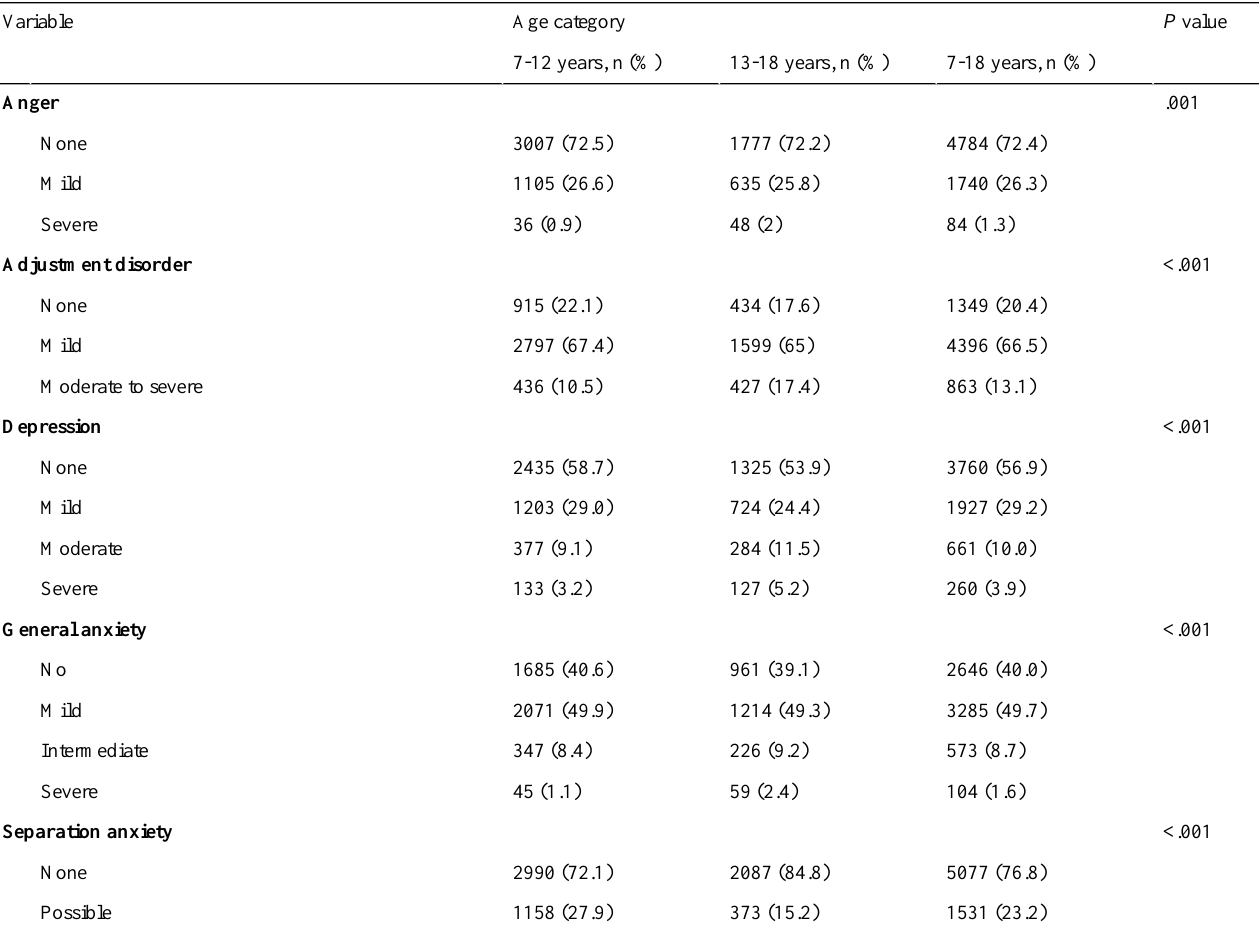
Table 8. Association between age categories in the study population and the final psychological diagnoses (clinical outcomes) (N=6608).